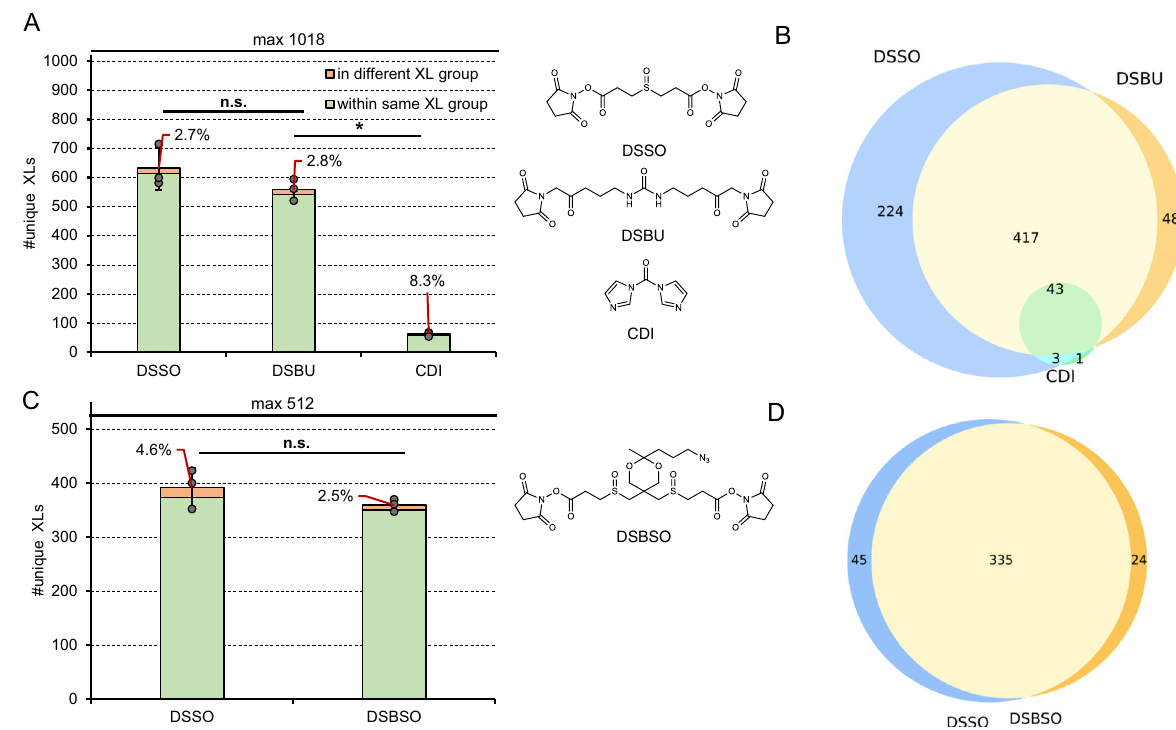
Fig. 3 Benchmarking the linker reagents DSSO, DSBU, CDI and DSBSO. Average number of unique crosslink IDs after acquisition using a stepped HCD MS2 strategy and maximal theoretical number of true link combinations when applying the indicated crosslinkers to the main library ( A ) or the enrichable library ( C ) and data analysis using MS Annika at 1% estimated FDR. The experimentally validated FDR is shown as callout, error-bars indicate standard deviations of average values, n = 3 independent samples acquired on different days, unpaired Student ’ s t test, two tailed, α = 0.05, * P < 0.05, n.s. = not signi fi cant. Obtained P values: DSSO vs DSBSO: 0.1947, DSBSO vs CDI: < 0.0001, DSSO vs DSBSO: 0.2149 ( B and D ) Overlap of identi fi ed links from one representative replicate of ( A ) (in B ) or ( C ) (in D ) respectively. Source data are provided as a Source Data fi